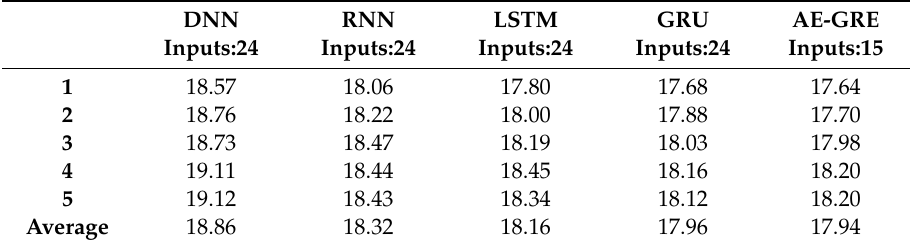
Table 6. RMSE results of different models under 5-fold cross-validation (Time steps = 5).